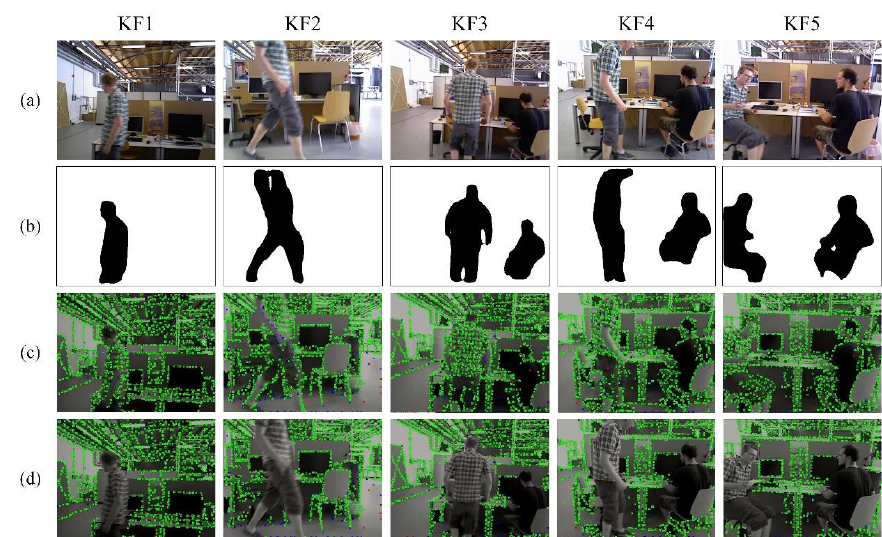
Figure 7. Comparison of Dynamic-DSO and DSO for extracting candidate points in keyframes. ( a ):